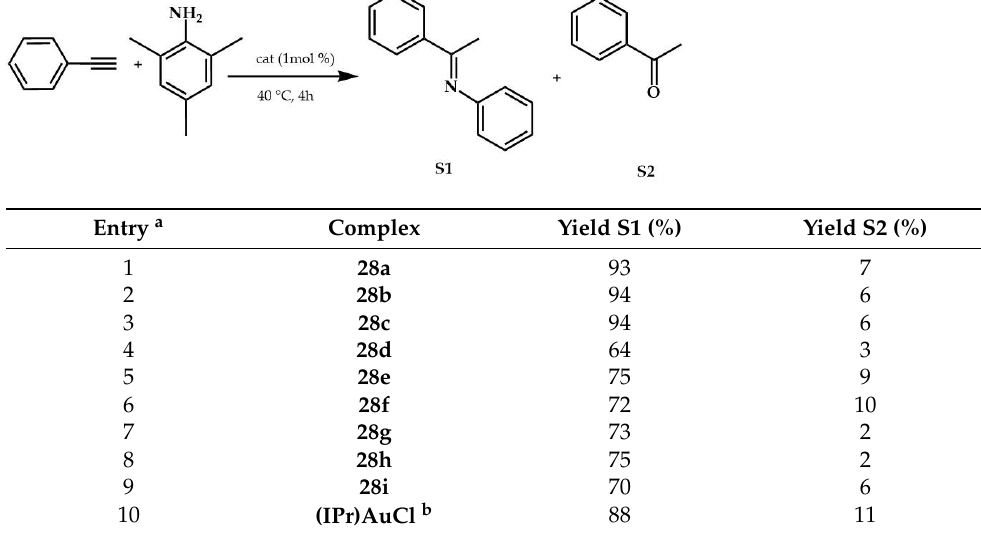
Entry a Complex Yield S1(%) Entry a Entry a